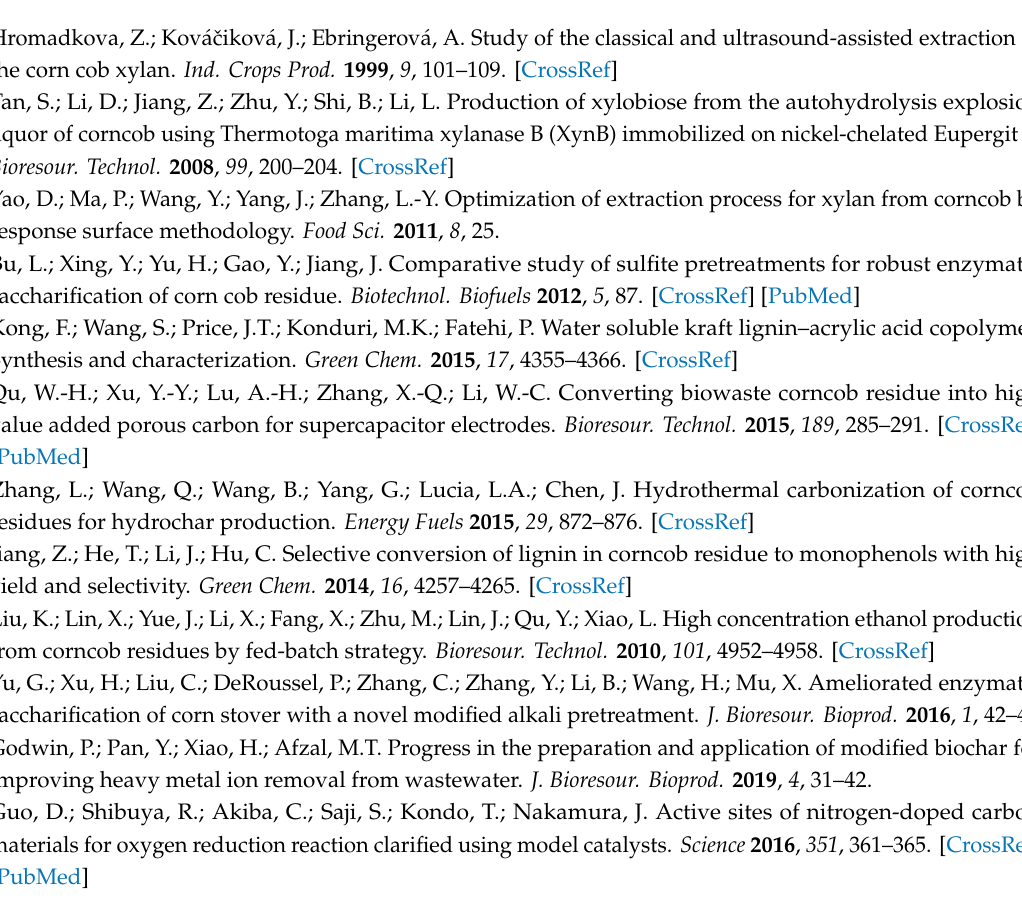
Figure S1. SEM images of (a) 500 × Hydrochar; (b) 5000 × BC-H3PO4; (c) 4800 × BC-ZnCl2. Figure S2. XRD of Hydrochar, BC-H 3 PO 4 and BC-ZnCl 2 . Table S1. Kinetic fitting parameters of the PFO, PSO and IPD models for the BC-H 3 PO 4 removal of Cd (II) and Cu (II). Table S2. Kinetic fitting parameters of the PFO, PSO and IPD models for the BC-ZnCl 2 removal of Cd (II) and Cu